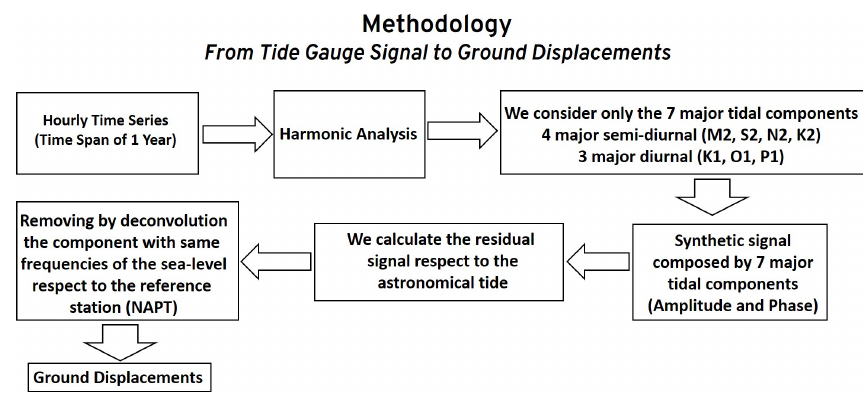
Figure 3. Flowchart of the methodology used in this paper to retrieve ground displacements from the tide gauge signal.